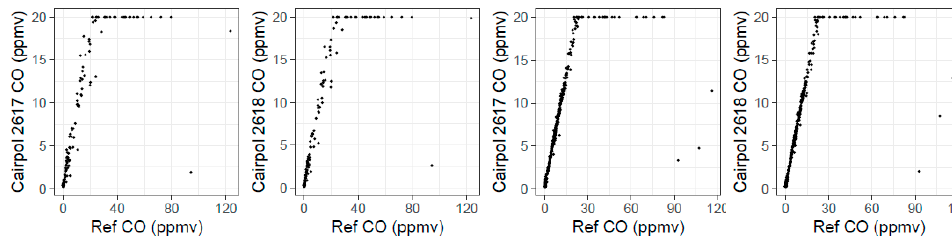
Figure 6. Timeseries of reference, Aeroqual, and Cairpol CO measurements during seven days of Tallgrass Prairie prescribed burn experiments in 2017.